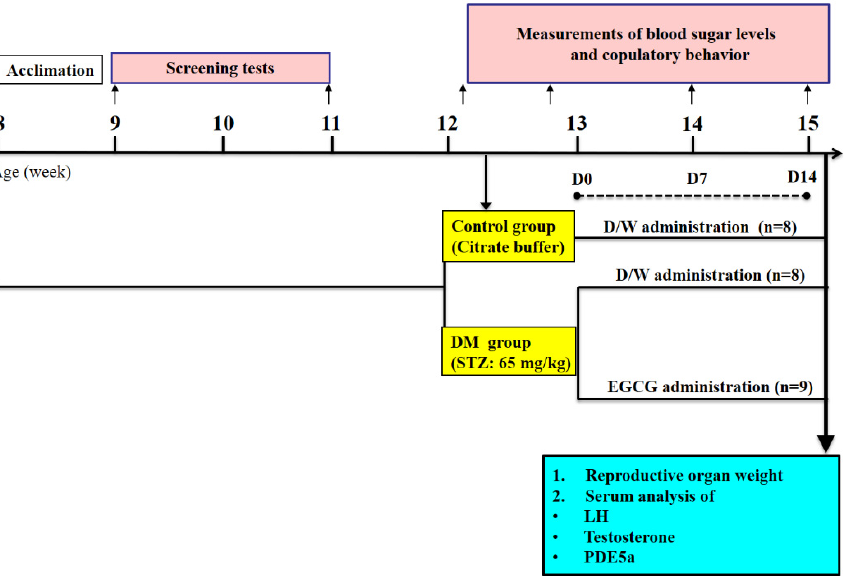
Figure 6. Schematic of study design. After STZ-induced diabetes, animals were treated with 40 mg/kg of EGCG or distilled water. Blood glucose levels and sexual behavior tests were performed before, and after 7 and 14 days of treatment. After the last behavioral test, the animals were sacrificed, and blood was collected for serum LH, testosterone, and PDE5a analysis.